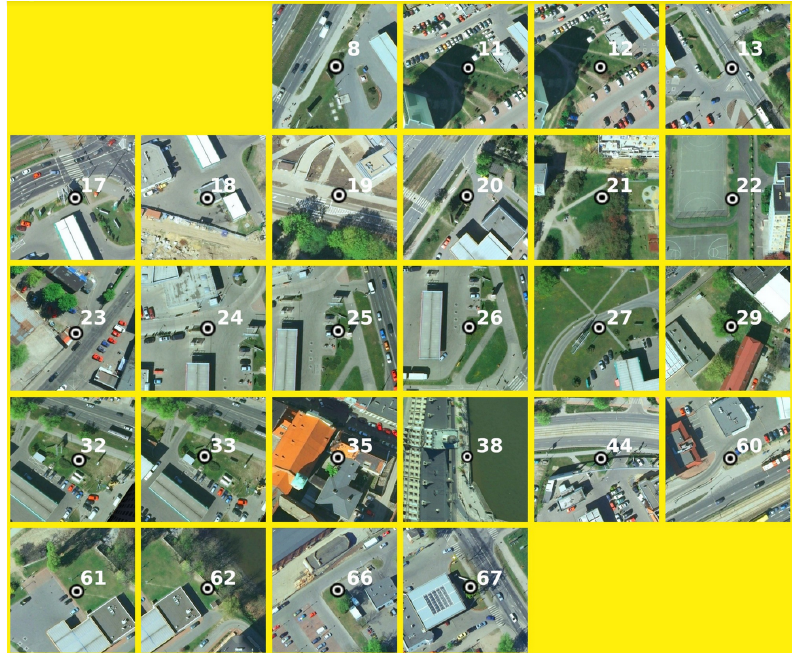
Figure A2. Higher GWT (HGWT) assimilated to GUHI.